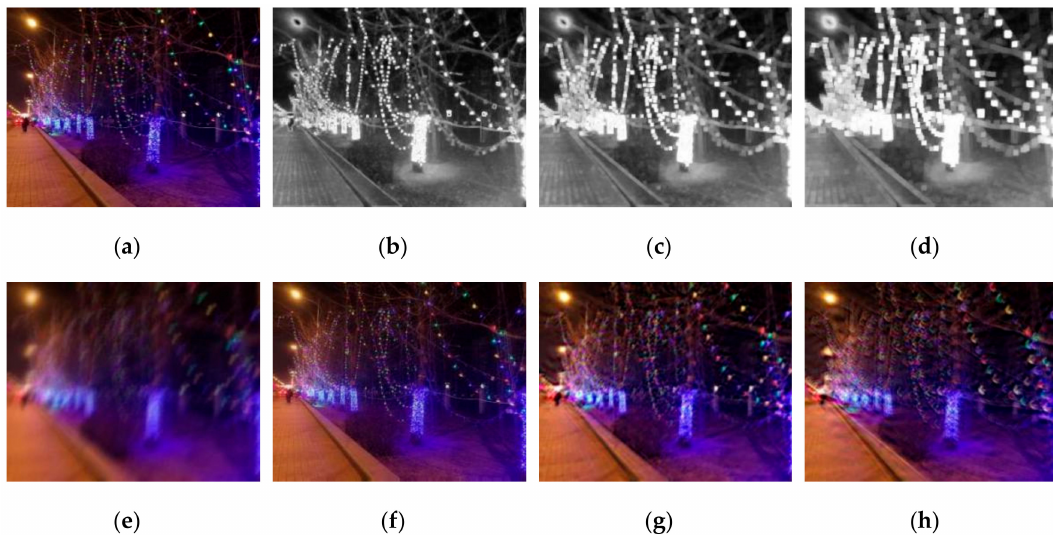
Figure 3. ( a ) Clear image, ( b ) edges selected with the window size = 5 × 5, ( c ) edges selected with the window size = 7 × 7, ( d ) edges selected with the window size = 9 × 9, ( e ) blurred image, ( f ) deblurring result with the window size = 5 × 5, ( g ) deblurring result with the window size = 7 × 7, ( h ) deblurring result with the window size = 9 × 9.